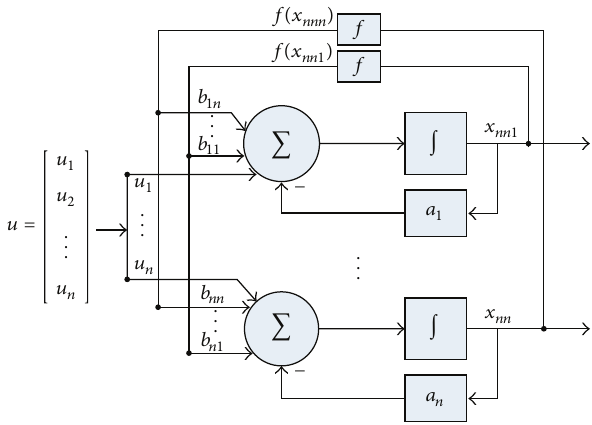
Figure 3: The architecture of DNN-based